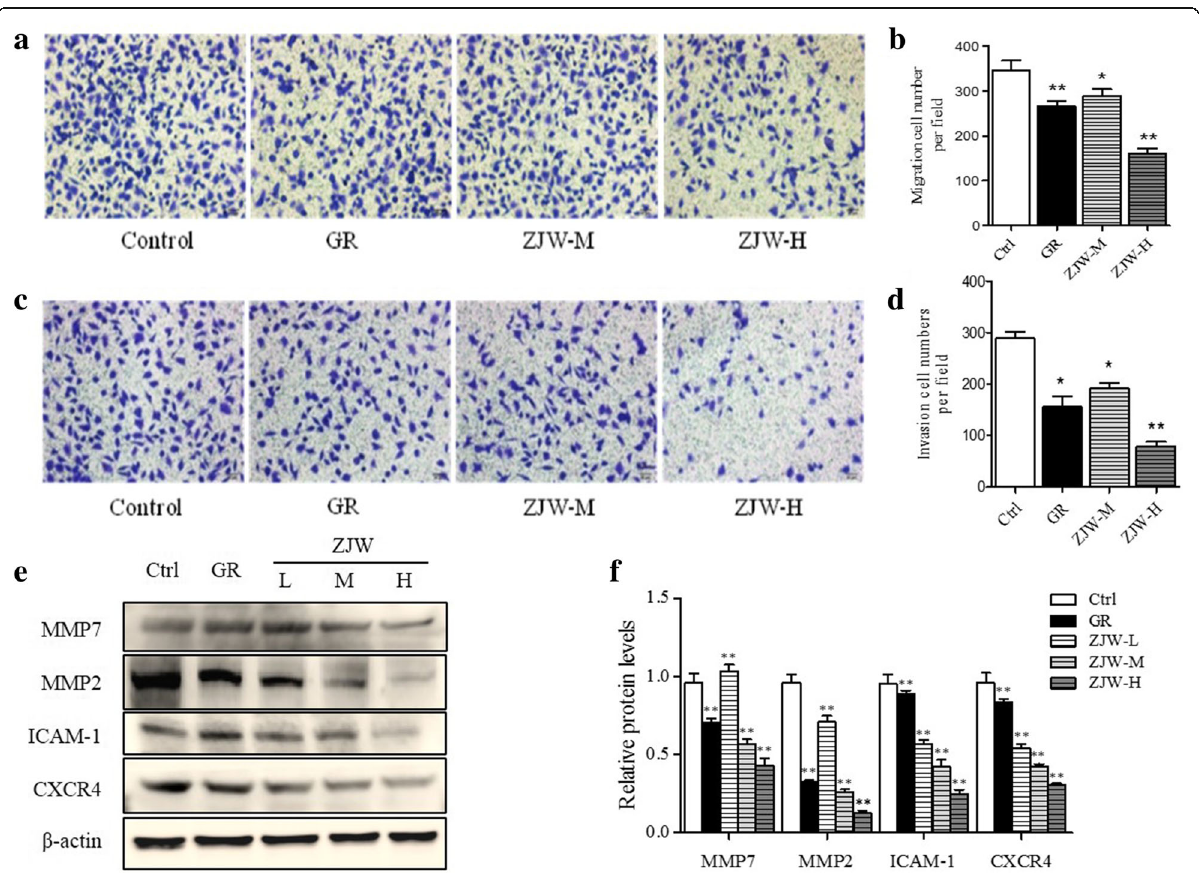
Fig. 4 Effect of the ZJW extracts treatment on cell migration and invasion. a Migration assay of SW403 cells treated with ZJW-M, ZJW-H, GR (5 μ mol/L) for 18 h. The underside of the filer was stained by crystal violet and observed through microscope (200×). b Migrated cells were counted under a microscope at a magnification of 200× (5 fields/filter). c Invasion assay of SW403 cells treated with ZJW-M, ZJW-H, GR (5 μ mol/L) for 18 h. d Cells passed through the Matrigel and filer were counted under a microscope at a magnification of 200× (5 fields/filter). e Representative western blots of MMP2, MMP7, ICAM-1 and CXCR4 in SW403 cells treated with GR (5 μ mol/L), ZJW-L, ZJW-M or ZJW-H. f The corresponding semi-quantification data of ( e ). All values are shown as mean±SD of three separate experiments, and significant values are indicated with asterisks (* P <0.05, ** P <0.01 vs.